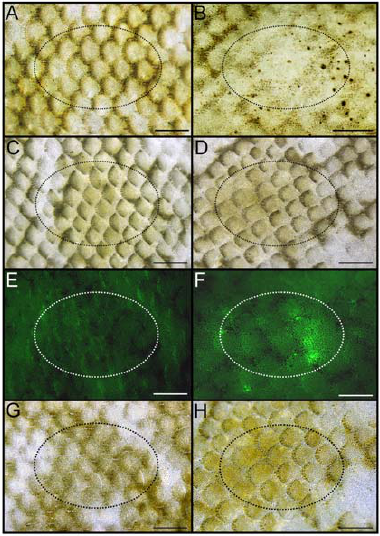
Figure 8. Views of dorsal skin of sole injected and eletropo- rated invivo to evaluate the effect of asip 1 overexpression on skin paling. Animals were injected with about 10 m g of capped sense (B) or antisense (D) mRNA per cm 2 of dorsal skin and the effect was evaluated 4 days post injection/electroporation. Dorsal skin of control non-treated turbots are shown in A, C, E, and G. E and F show dorsal skin of control (E) and injected/electroporated animals with capped sense eGFP-mRNA (F) animals under fluorescent incident light. G and H display animals shown in E and F under brilliant incident light. See Figure 7 for more details. Dorsal views, anterior to the right. Scale bars: